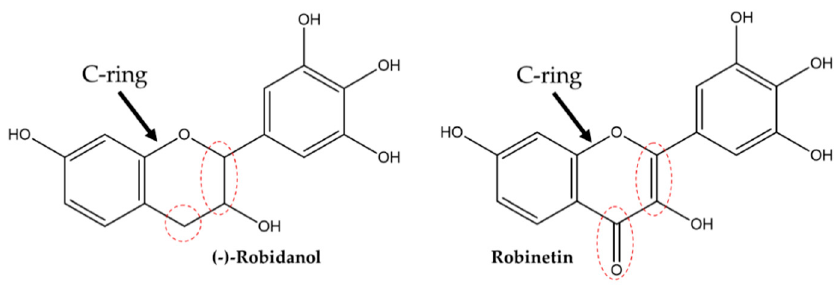
Figure 4. The difference between the molecular structure of robidanol and robinetin.